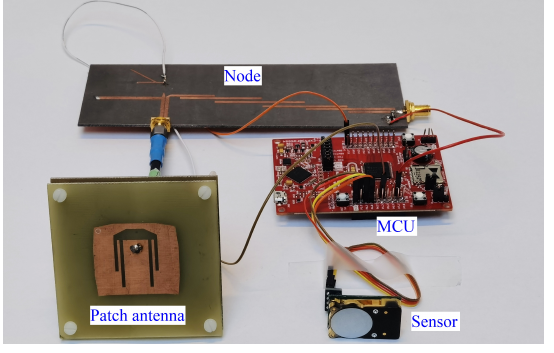
Figure 6. Structure of the sensor node.